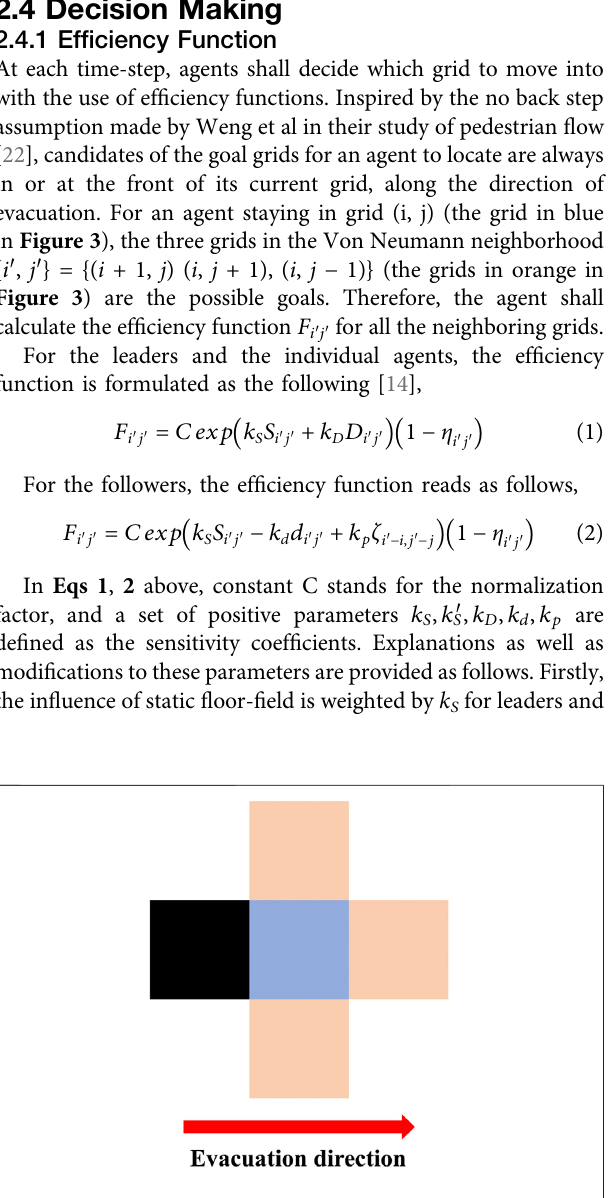
FIGURE 3 | Candidates of target orange grids for an evacuation agent stayinginthecentralbluegrid.Underno-back-stepassumption,entranceinto the black grid is forbidden for the